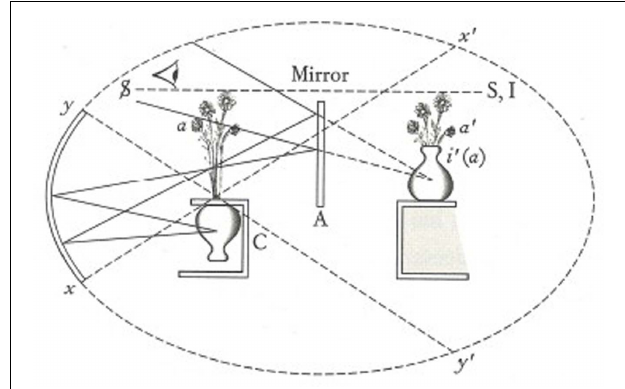
FIGURE 1 | Lacan’s double-mirror device (Lacan, 2006e). Reprinted from ECRITS by Jacques Lacan, translated by Bruce Fink. English translation copyright © 2006, 2002 byW.W. Norton & Company, Inc. Used with permission of the publisher,W.W. Norton & Company,